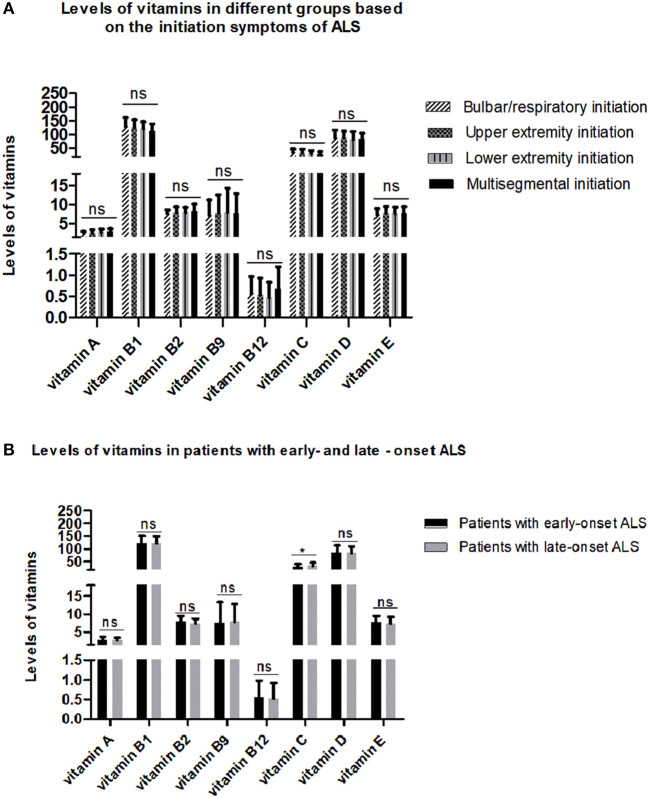
Levels of different vitamins in different amyotrophic lateral sclerosis (ALS) patient groups. (A) Patients with ALS were grouped by sites of disease onset. (B) Patients with ALS were divided by age at onset. ns denotes non-significant; * denotes p < 0.05.